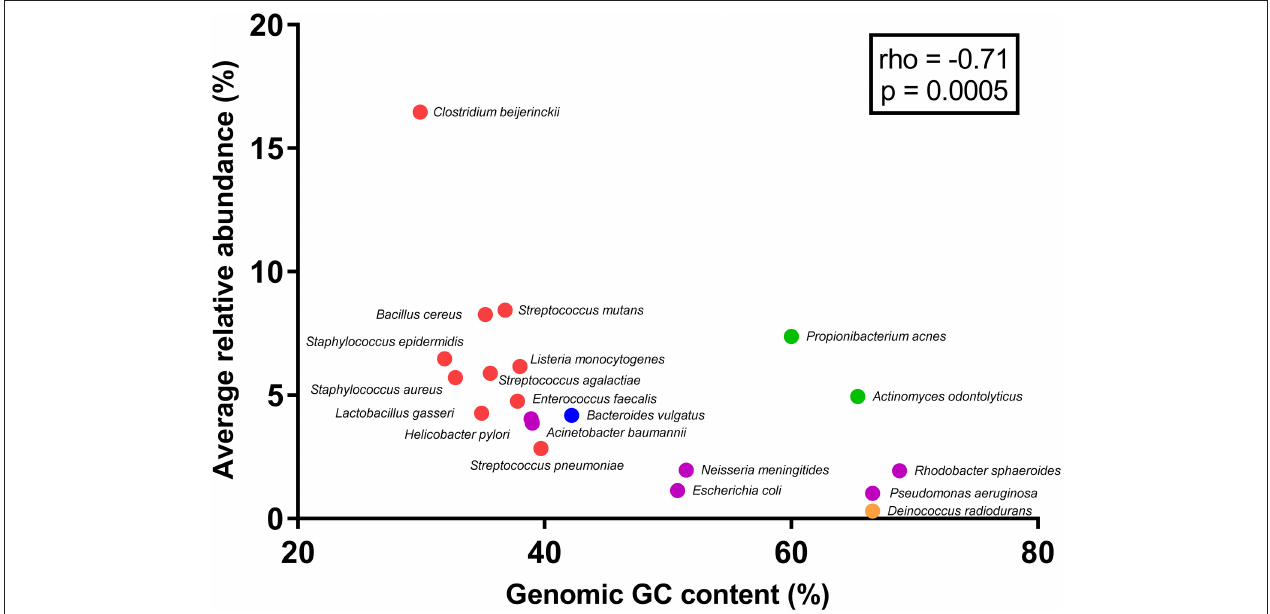
FIGURE 3 | Correlation between genomic GC content and average abundance estimates for the 20-member mock community. Dots are colored according to phylum (Blue: Bacteroidetes, Purple: Proteobacteria, Green: Actinobacteria, Red: Firmicutes, and Yellow: Deinococcus-Thermus). Spearman’s rank correlation coefficient (rho) and resulting p -value for the association is shown in the